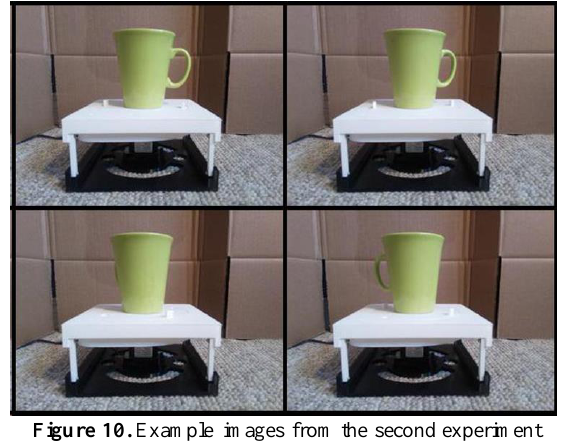
Figure 10. Example images from the second experiment